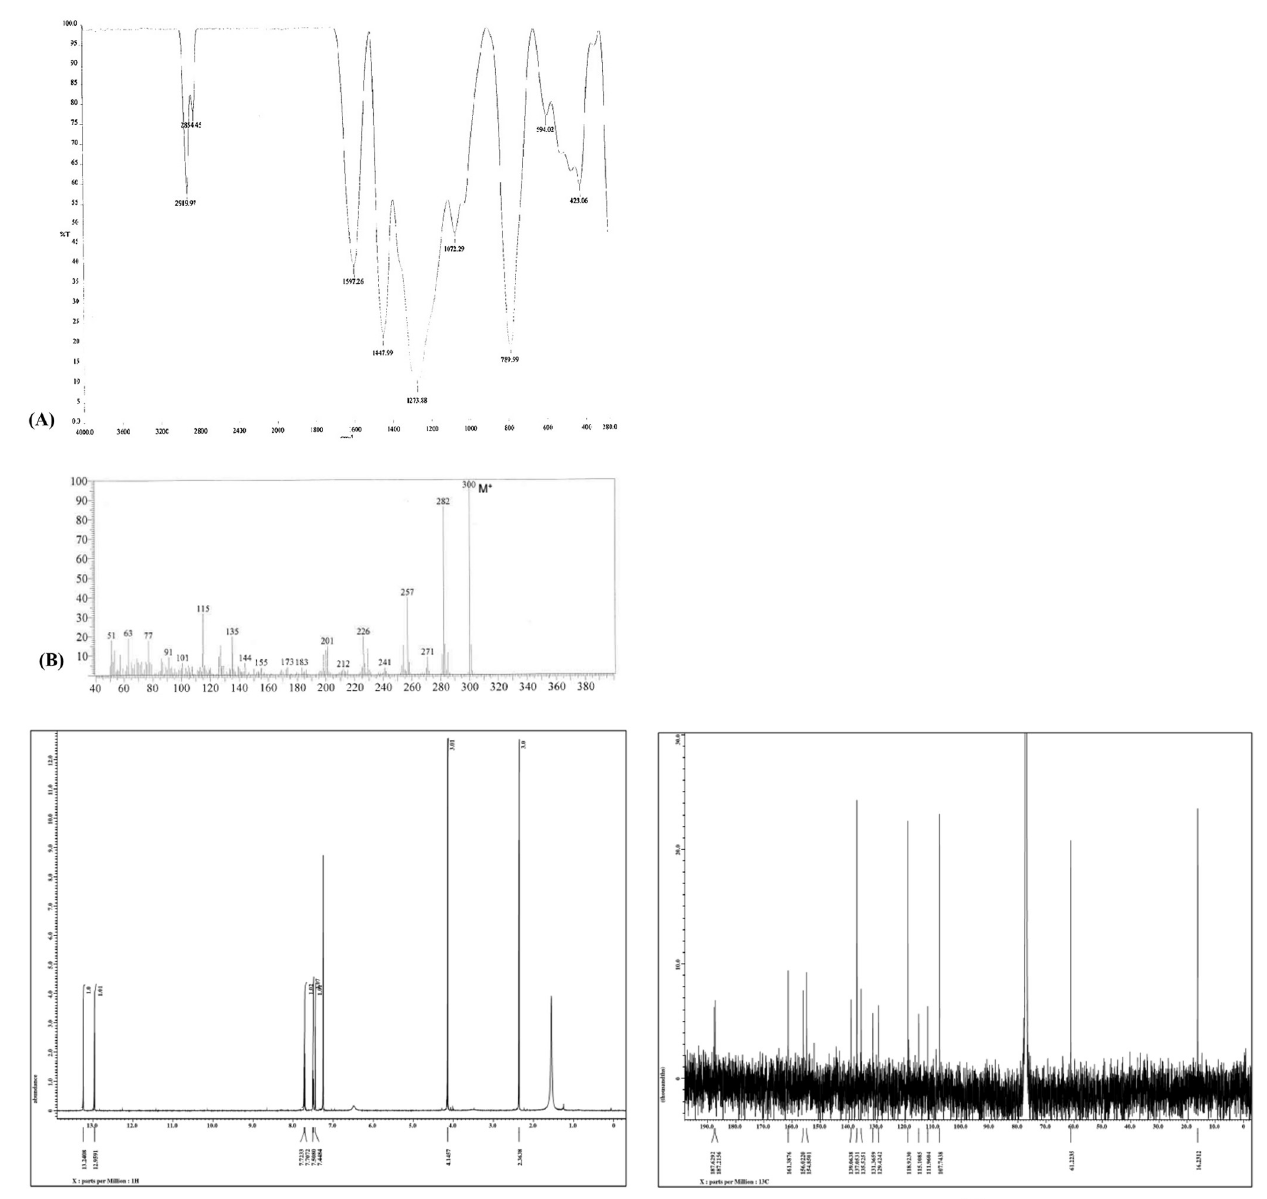
Fig 8. Characterization of morindone. (A) FTIR spectrum of morindone. (B) GC-MS chromatogram of morindone. (C) 1 H NMR spectra of morindone in Acetone-d 6 . (D) 13 C NMR spectra of morindone in Acetone-d 6